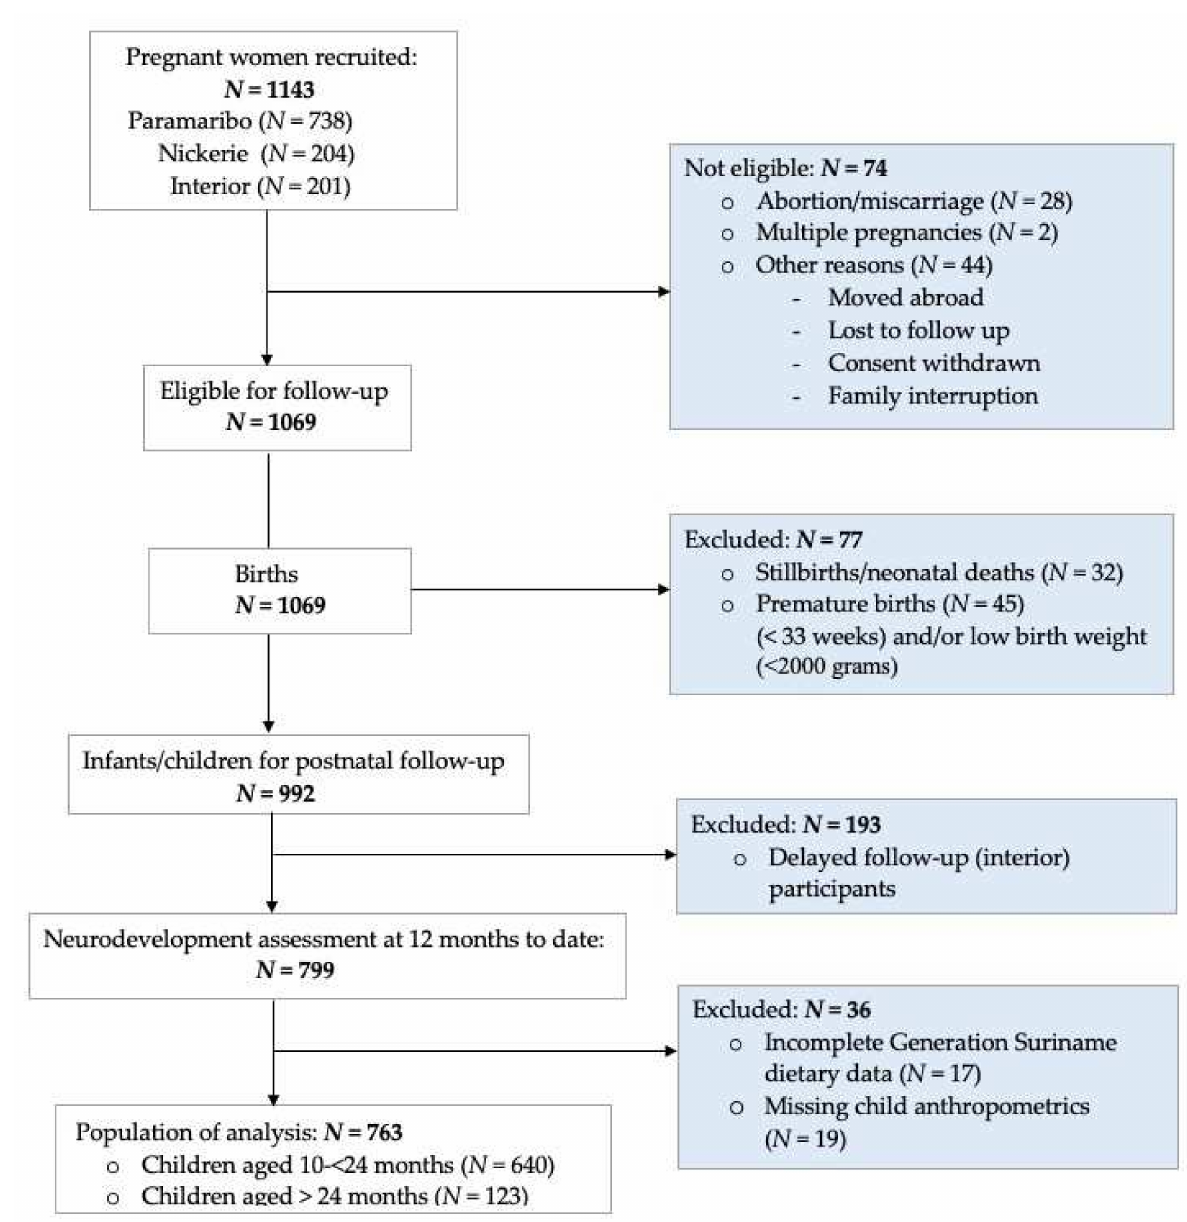
Figure 1. Flowchart with participant